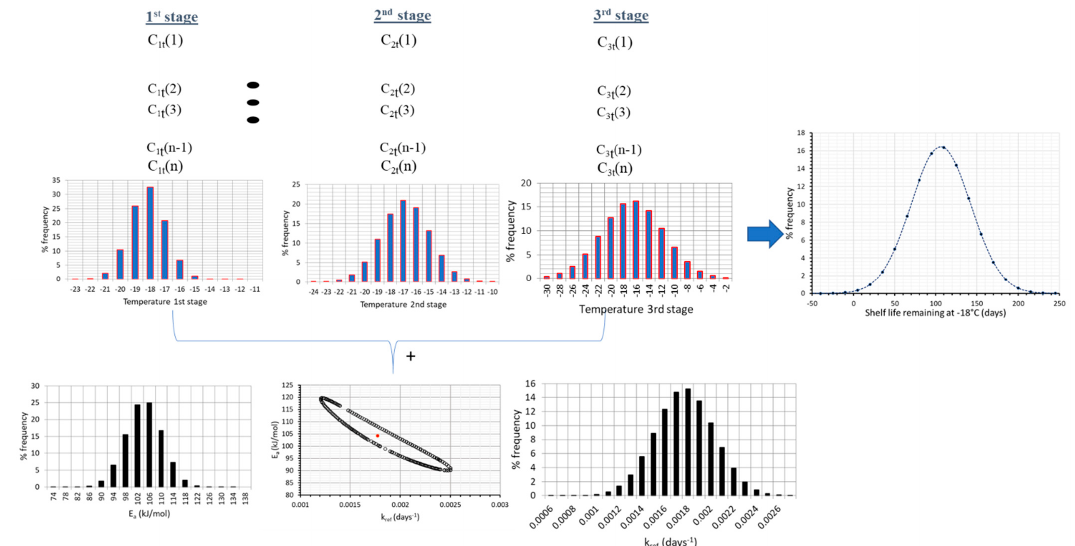
Figure 5. Flow chart of the methodology used, showing the remaining shelf life of frozen green peas, after 130 days in the cold chain, when both temperature variability and parameter uncertainty were incorporated within model’s prediction algorithm.